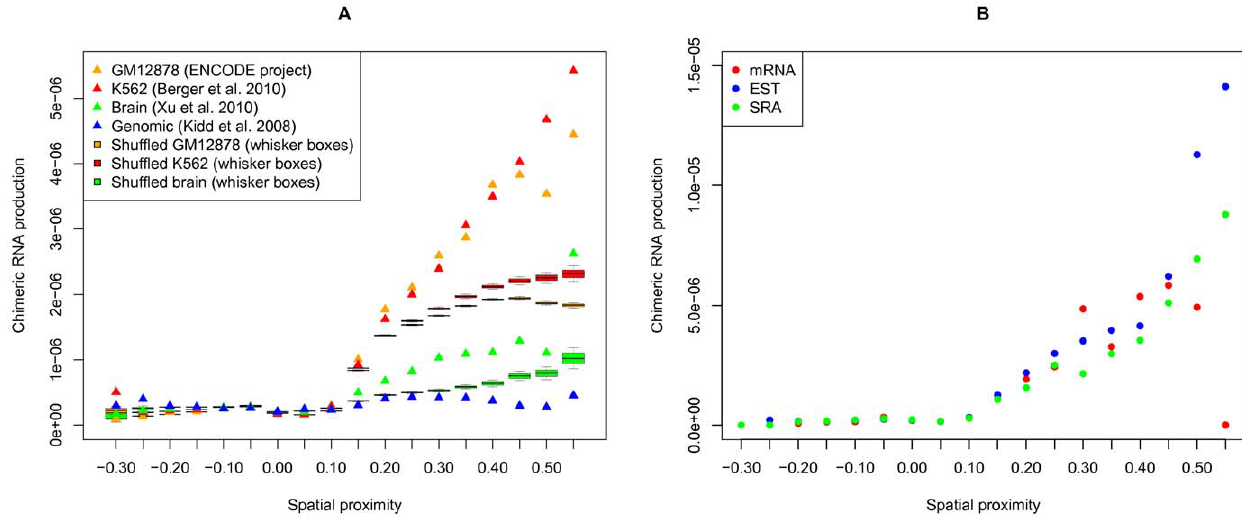
Figure 10. Correlation between chimeric RNA production and spatial proximity values for (A) the K562 cell line, the GM12878 cell line, and the brain tissue sample (red, orange and green triangles, respectively); the genomic rearrangement dataset (shown in blue); the shuffled control K562 dataset (red whisker boxes); the shuffled control GM12878 dataset (orange whisker boxes); the shuffled control brain dataset (green whisker boxes) and (B) three ChimerDB datasets: mRNA, EST and SRA-derived (red, blue and green dots, respectively).